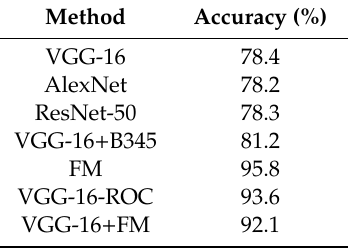
Table 2. The detection results of our model and the comparison to only DCNNs. “B345”represents the combination of “conv3_3”, “conv4_3”, and “conv5_3”, “ FM ” represents our front-end module, “VGG-16-ROC” means that the neural network input is only